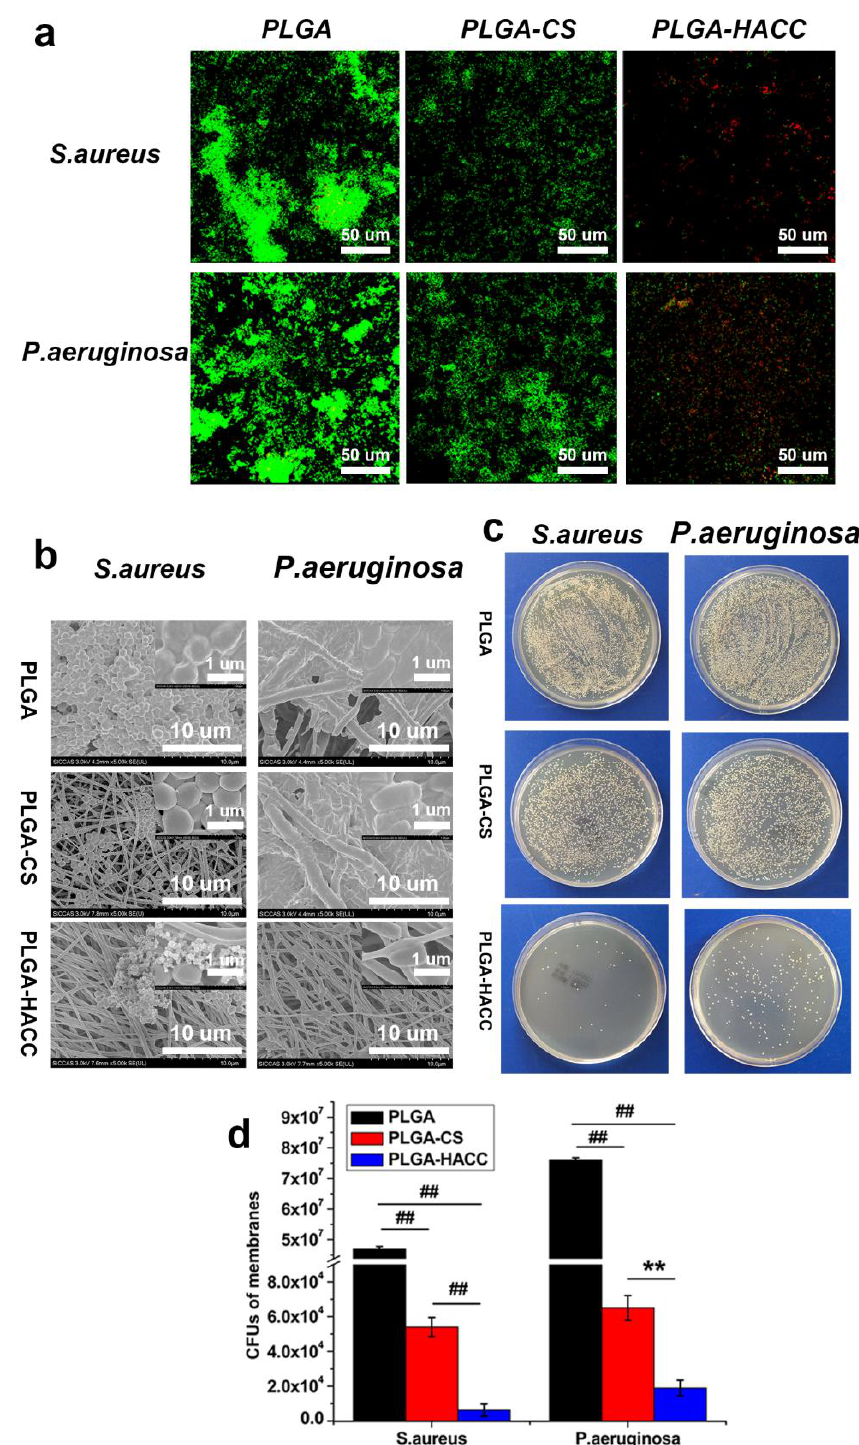
Figure 6. Images of S. aureus and P. aeruginosa activity on the surfaces of PLGA, PLGA-CS and PLGA-HACC fibrous membranes at 24 h obtained using CLSM ( a ); SEM images of S. aureus and P. aeruginosa incubation with PLGA, PLGA-CS and PLGA-HACC fibrous membranes at 24 h; the inset shows SEM images at a higher magnification ( b ); photographs of bacterial colonies formed by S. aureus and P. aeruginosa after incubation with PLGA, PLGA-CS and PLGA-HACC fibrous membranes for 24 h ( c ); quantity of adherent bacteria on the three membranes after 24 h of incubation ( d ); ## indicates p < 0.01, and ** indicates p < 0.05.